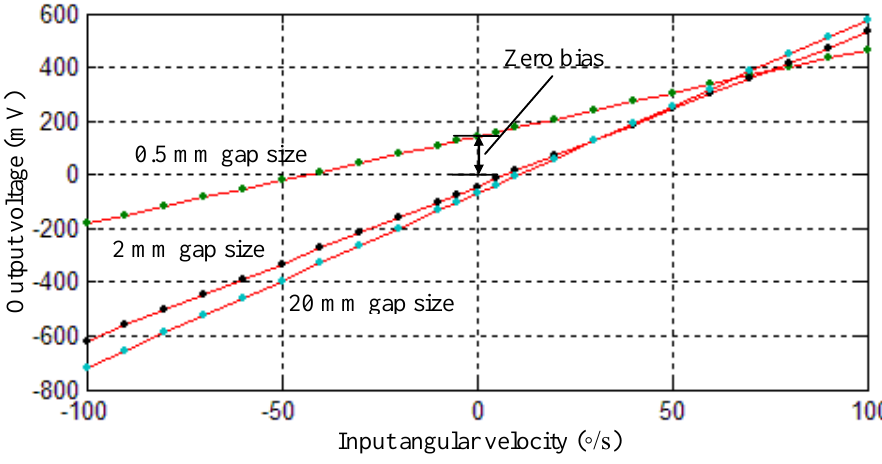
Figure 8. Scale factor test under different radial gap